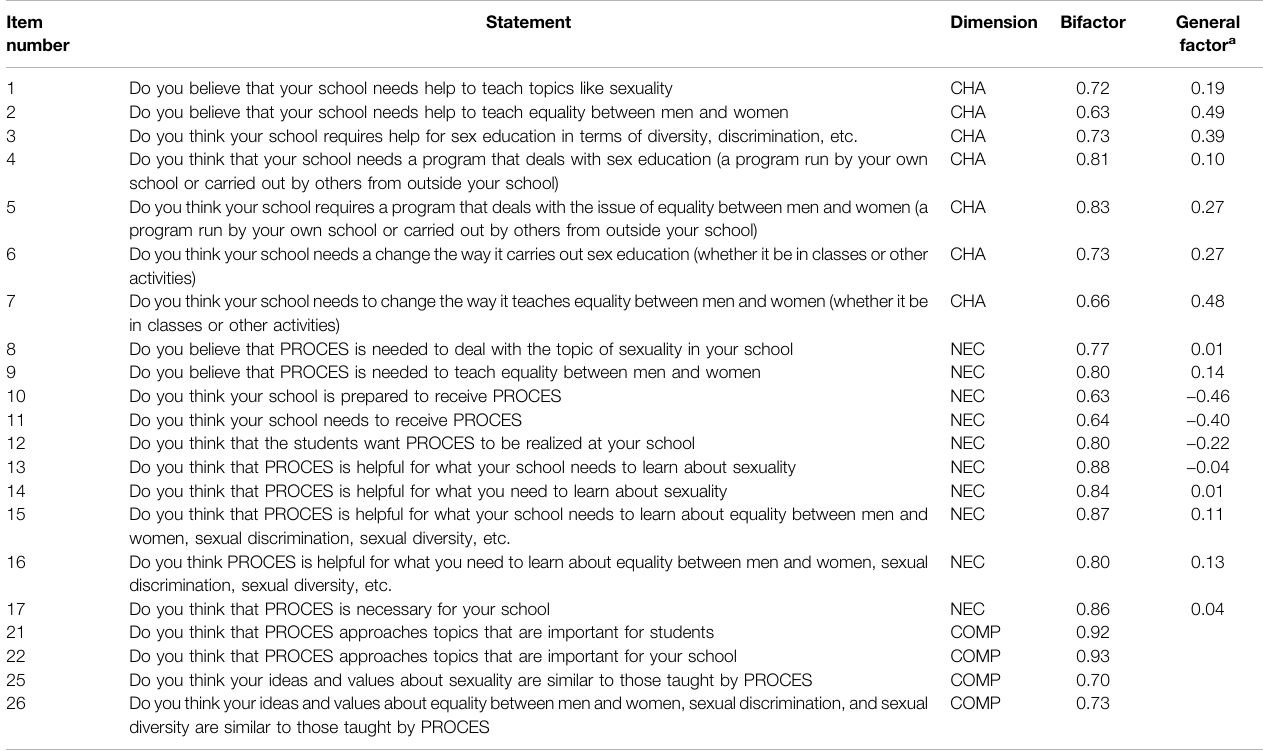
TABLE 1 | Factor loads of each item by bifactor model dimension for the Implementation Climate survey.